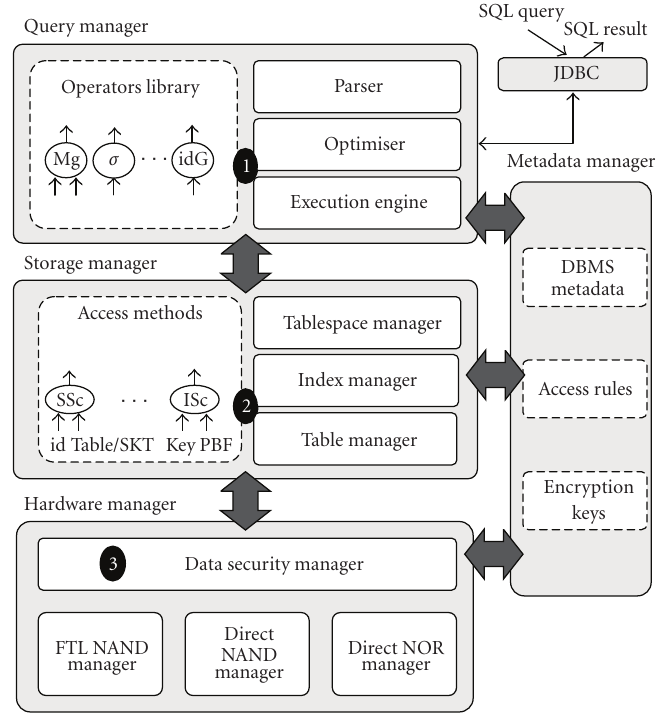
Figure 3: DBMS kernel